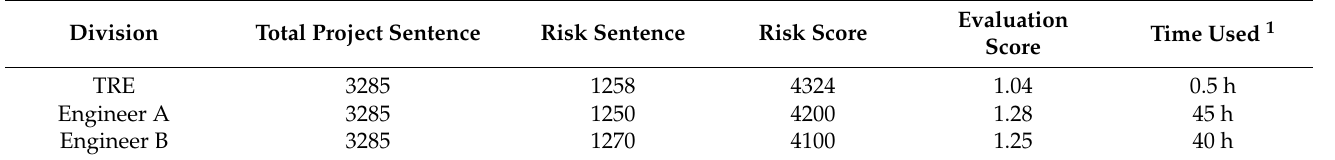
Table 10. Technical specification DPE module risk requirements extraction accuracy results.